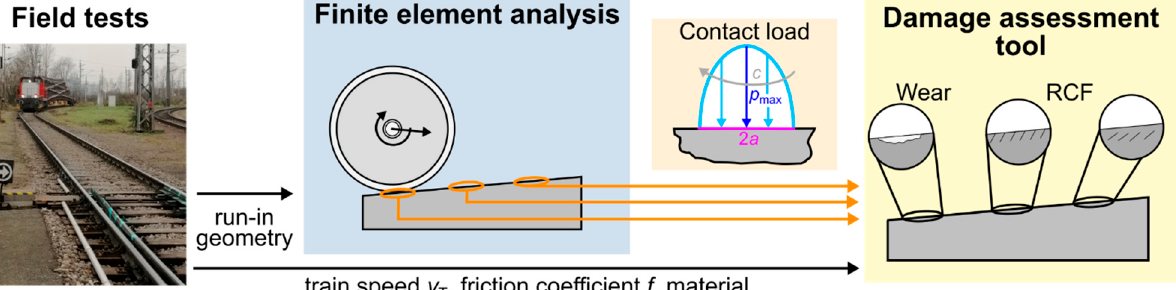
Figure 8. Workflow for the case study. Field tests provide the run-in geometry of the FEA model, the FEA computes the dynamic contact loads for different wheel profiles and the damage assessment tool predicts the damage evolution along the crossing nose.